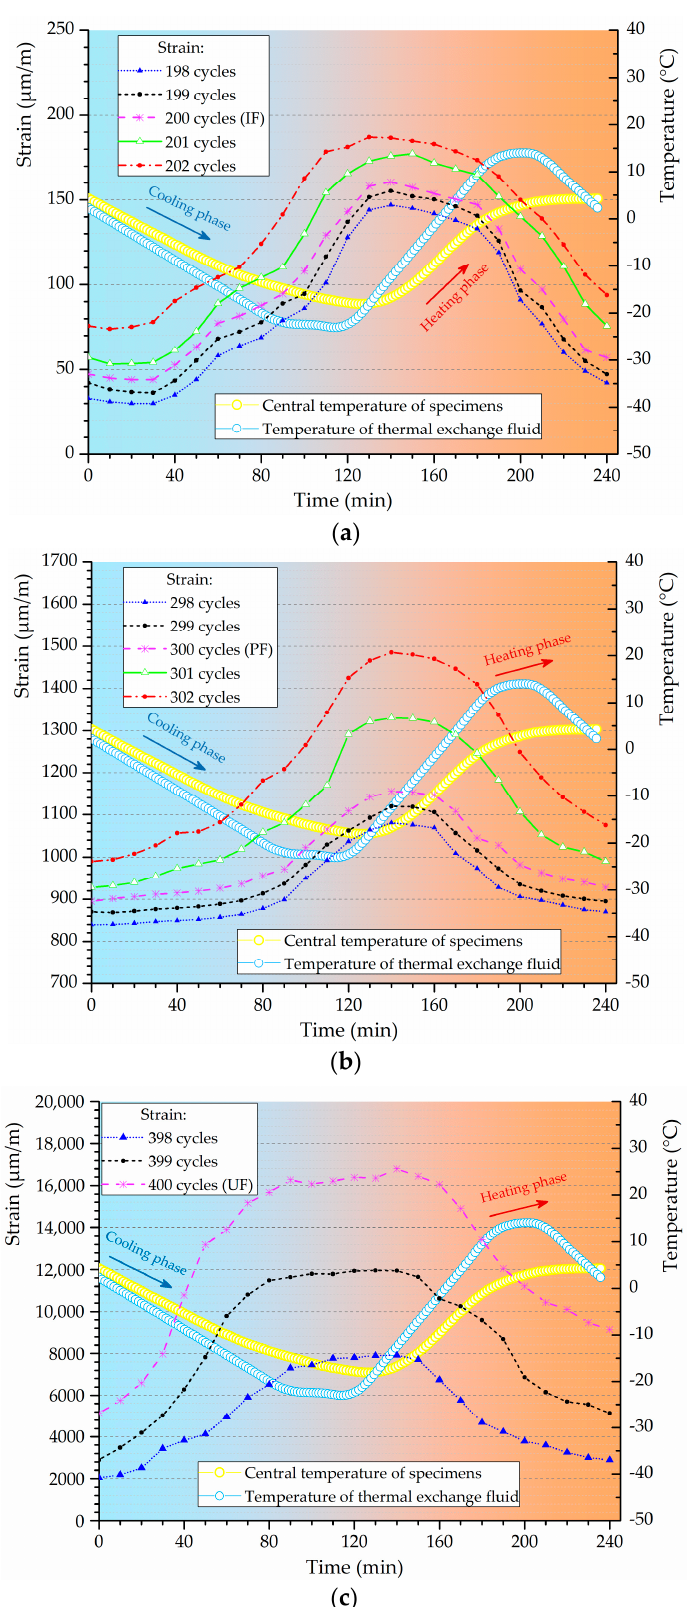
Figure 9. The evolving loss amplitude of engineering property for typical ECC mixtures: ( a ) Mix. 6; ( b ) Mix. 4; ( c ) Mix. 9.